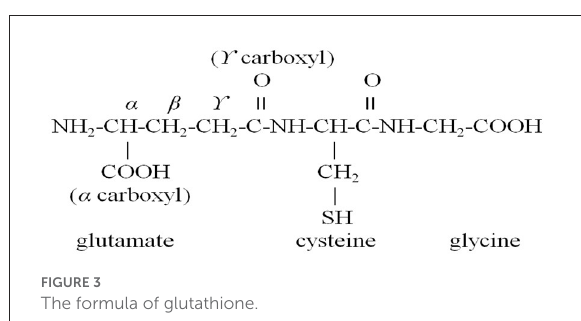
FIGURE3 The formula of